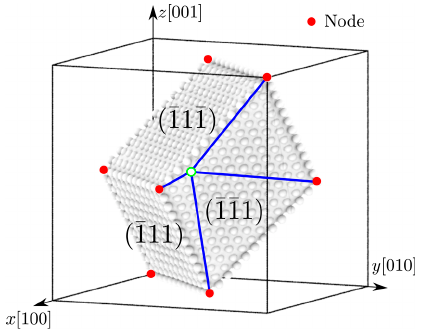
Figure 1. A 3D rhombohedral element with faces on {111} planes, the slip planes of FCC lattice. The position of each atom within each element, e.g., the green open circle, is interpolated from the nodal positions (red solid circles).